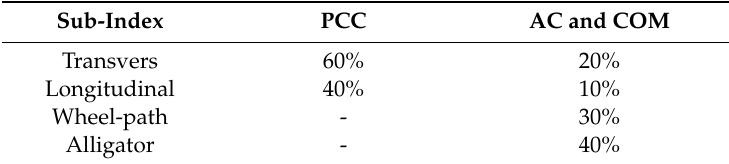
Table 3. Cracking sub-index weights for calculating Cracking Index by pavement